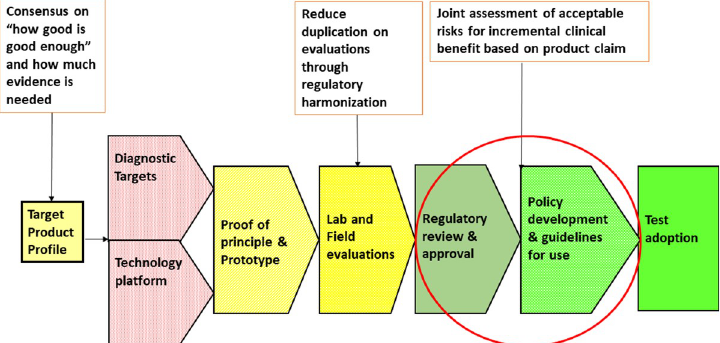
Fig 2. Proposed new regulatory policy framework to accelerate regulatory approval for IVD. IVD, in vitro